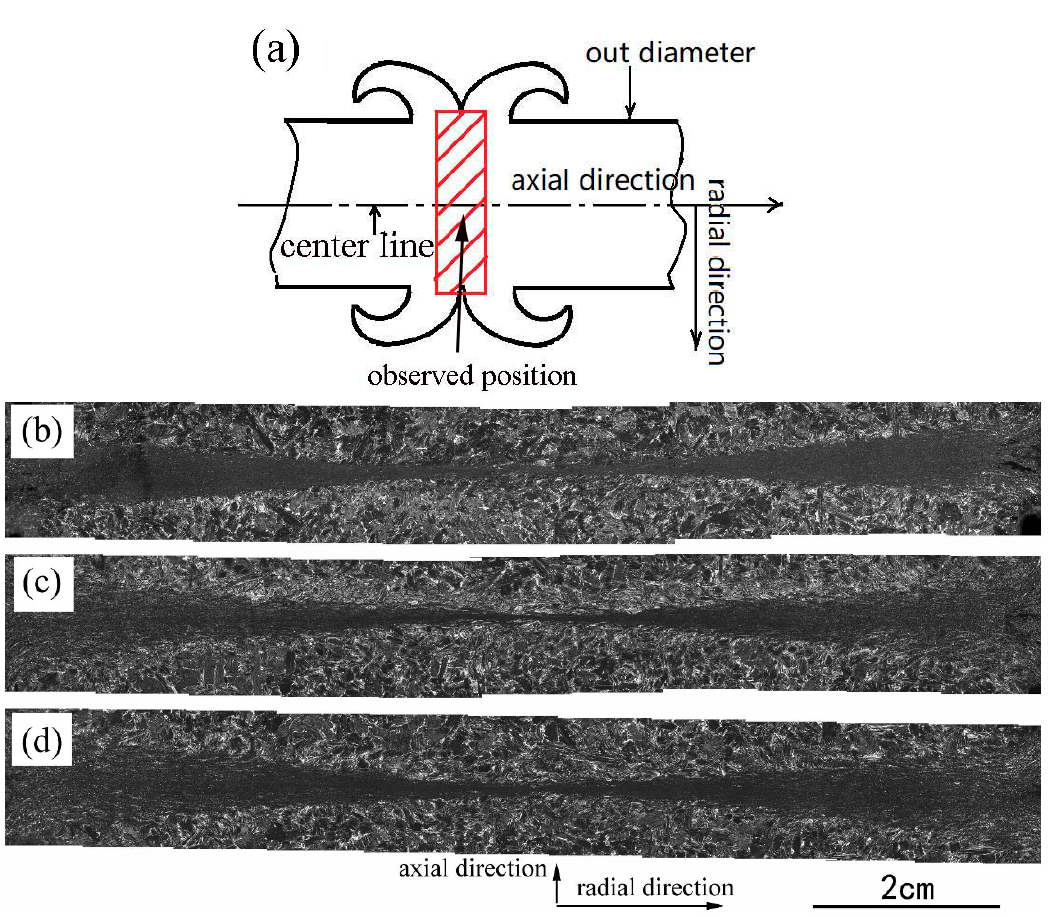
Figure 3. Macrostructures of the joints: ( a ) schematic diagram of observed position; ( b ) joint of Scheme 2; ( c ) joint of Scheme 5 and ( d ) joint of Scheme 6.